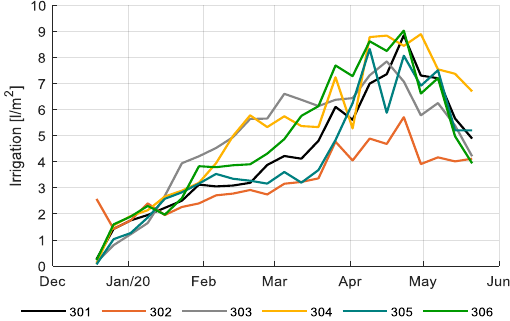
Figure 8. Daily CO 2 dosage (g/m 2 ) in different greenhouse compartments (301–306). Data smoothed by a moving average filter of 3 days.